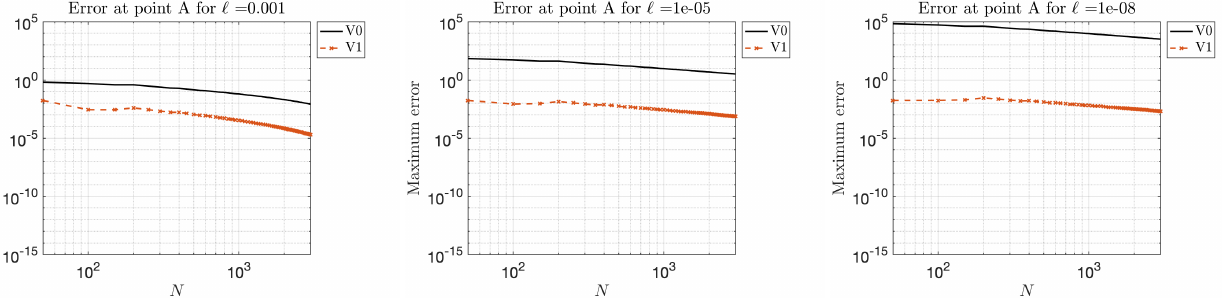
Figure 8. Helmholtz 2D. Log-log plots of the errors with respect to N made in computing the solution at some distance (cid:96) along the normal from point A plotted as black × ’s in Figure